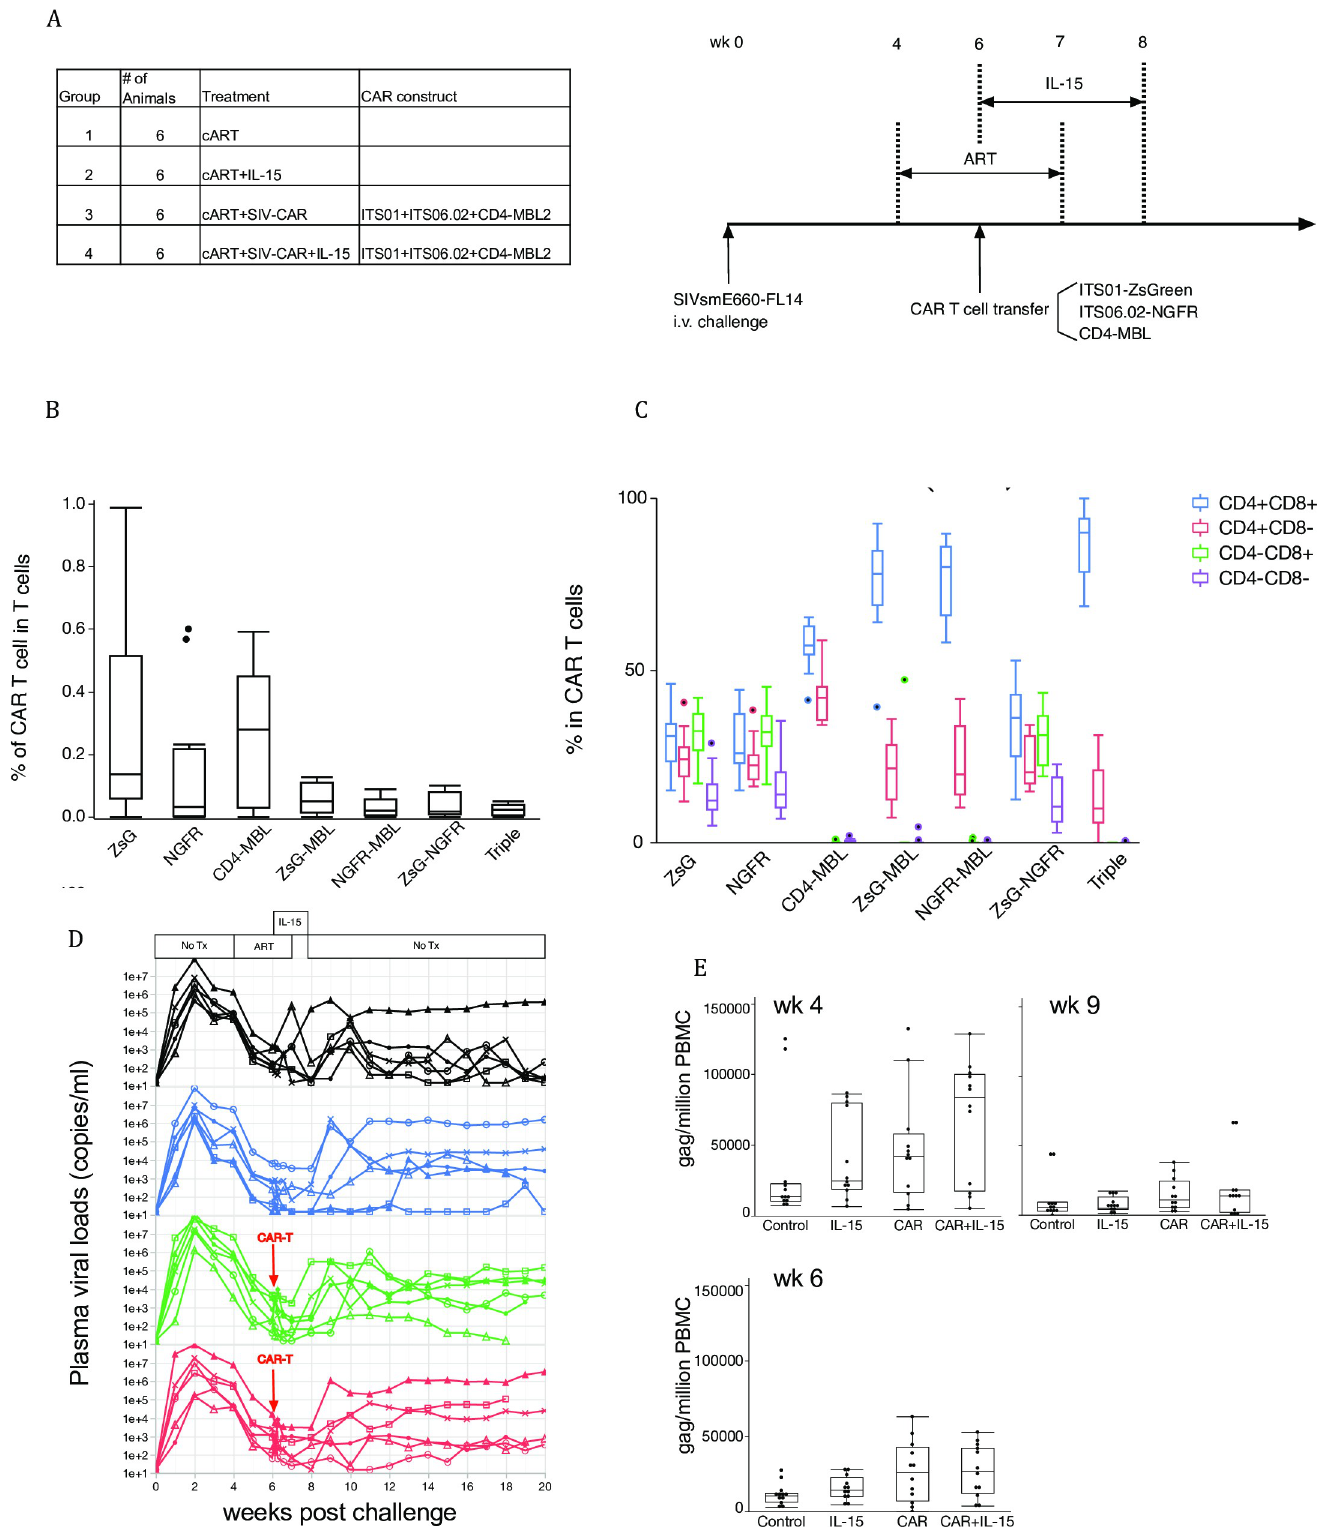
Fig 7. Combination therapy by CAR+IL-15. (A) Study groups of CRA+IL-15 study. Anti-SIV-CAR T cells were prepared from PBMC before infection and 1 week before CAR T cell transfer. ART started 2 weeks before CAR T cell transfer and continued for 3 weeks. IL-15 injection was initiated on the same day of CAR T cell